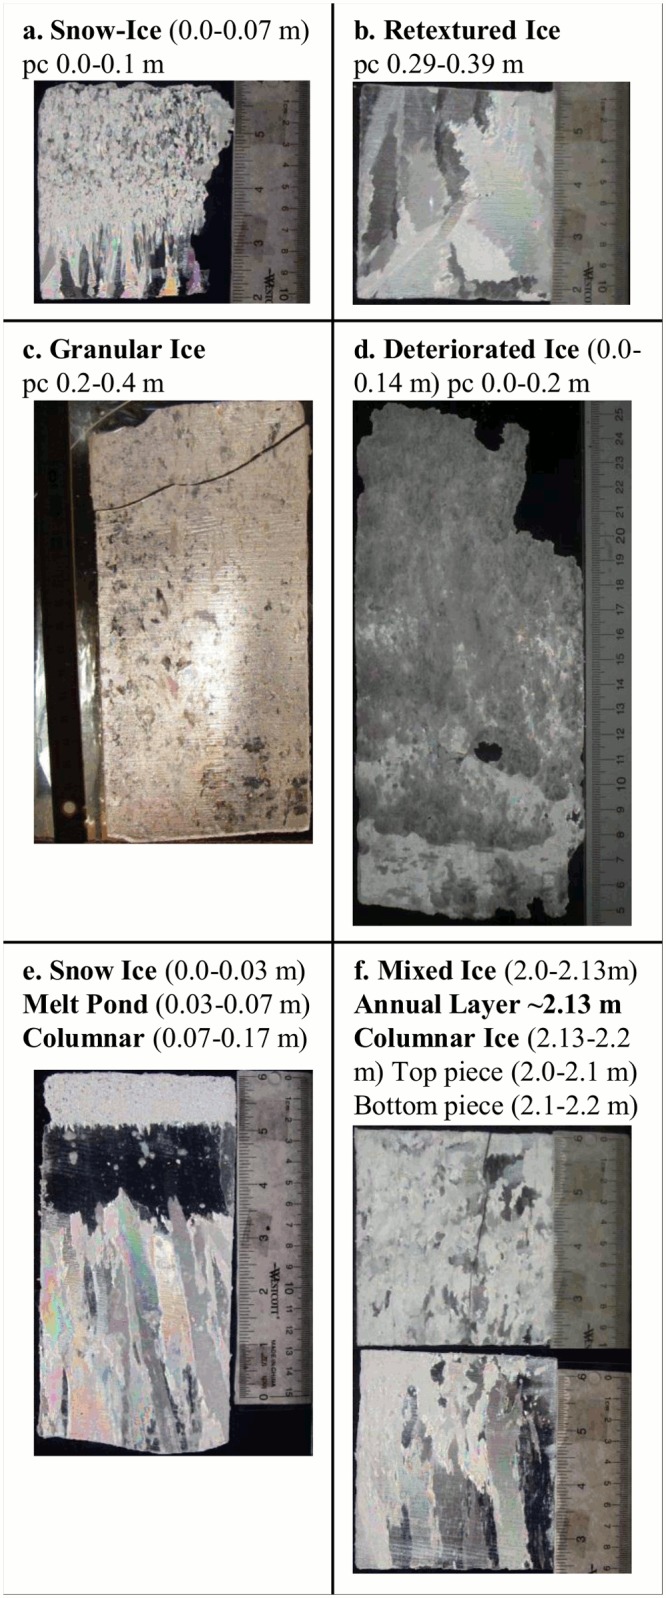
Cross polarized imagery of ice core thin sections showing different ice types.a) core 7–12; b) core 7–12; c) core 2–10; d) core 3–11; e) core 1–12; and f) core 7–12.